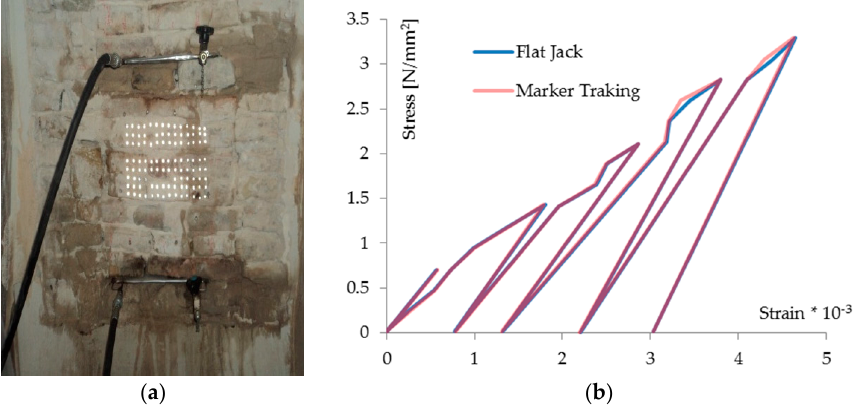
Figure 9. (a ) The test on a masonry wall inside the Oliverian Museum of Pesaro, ( b ) Stress-strain diagrams with the flat jack and the proposed technique (MT).